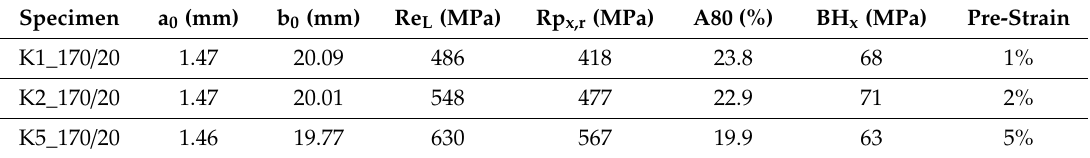
Table 4. Measured values of DP 500 HCT 590X, 170 °C/20 min.